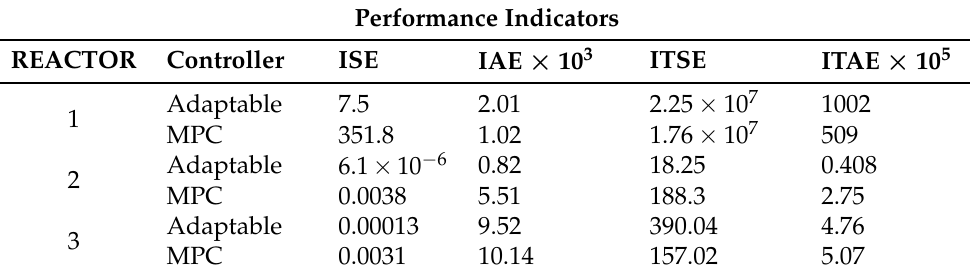
Table 2. Performance indicator of controllers simultaneous